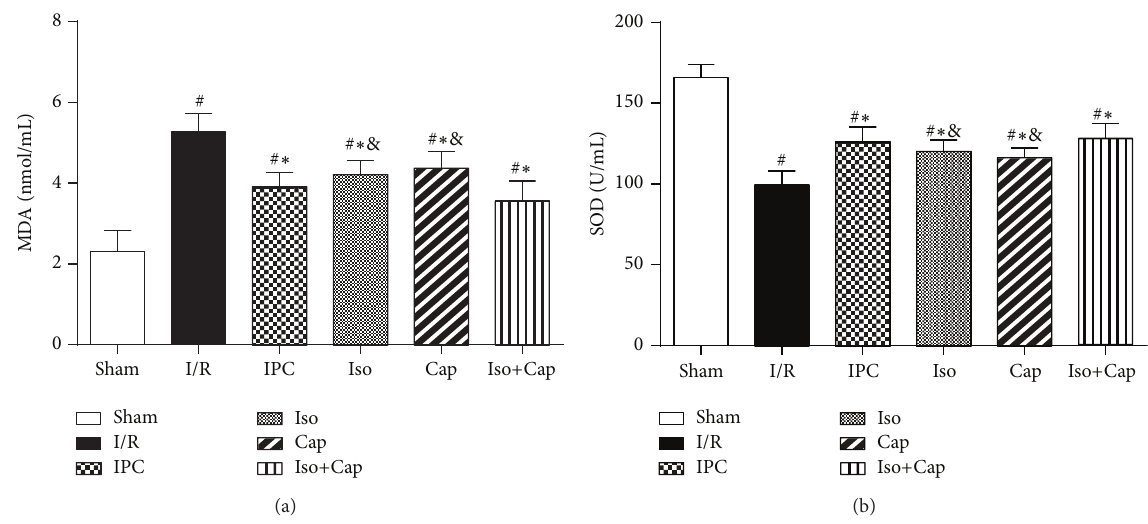
Figure 6: Isoflurane (Iso) and captopril (Cap) ameliorated postischemic myocardial oxidative stress in rabbits. (a) Cardiac malondialdehyde (MDA) content, (b) plasma superoxide dismutases (SOD) levels. Sham: sham operated control; I/R: rabbits subjected to myocardial ischemia reperfusion (MI/R); Cap: rabbits treated with captopril (25 mg/kg given intravenously 24 h) prior to inducing MI/R; Iso: rabbits received isoflurane preconditioning (15min 1.1% end tidal isoflurane followed by a 15min washout period before inducing MI/R); Iso+Cap: rabbits received captopril in combination with Iso. Data are shown as means ± SD, with 𝑛 = 8 animals per group. # 𝑃 < 0.05 versus Sham, ∗ 𝑃 < 0.05 versus I/R, and & 𝑃 < 0.05 versus